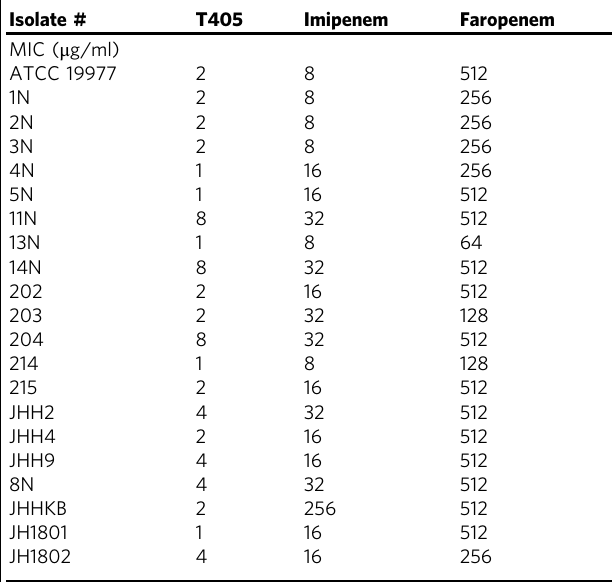
Table 1 MICs of T405, imipenem and faropenem tested against the reference strain (ATCC 19977) and 20 clinical strains of M. abscessus in vitro.